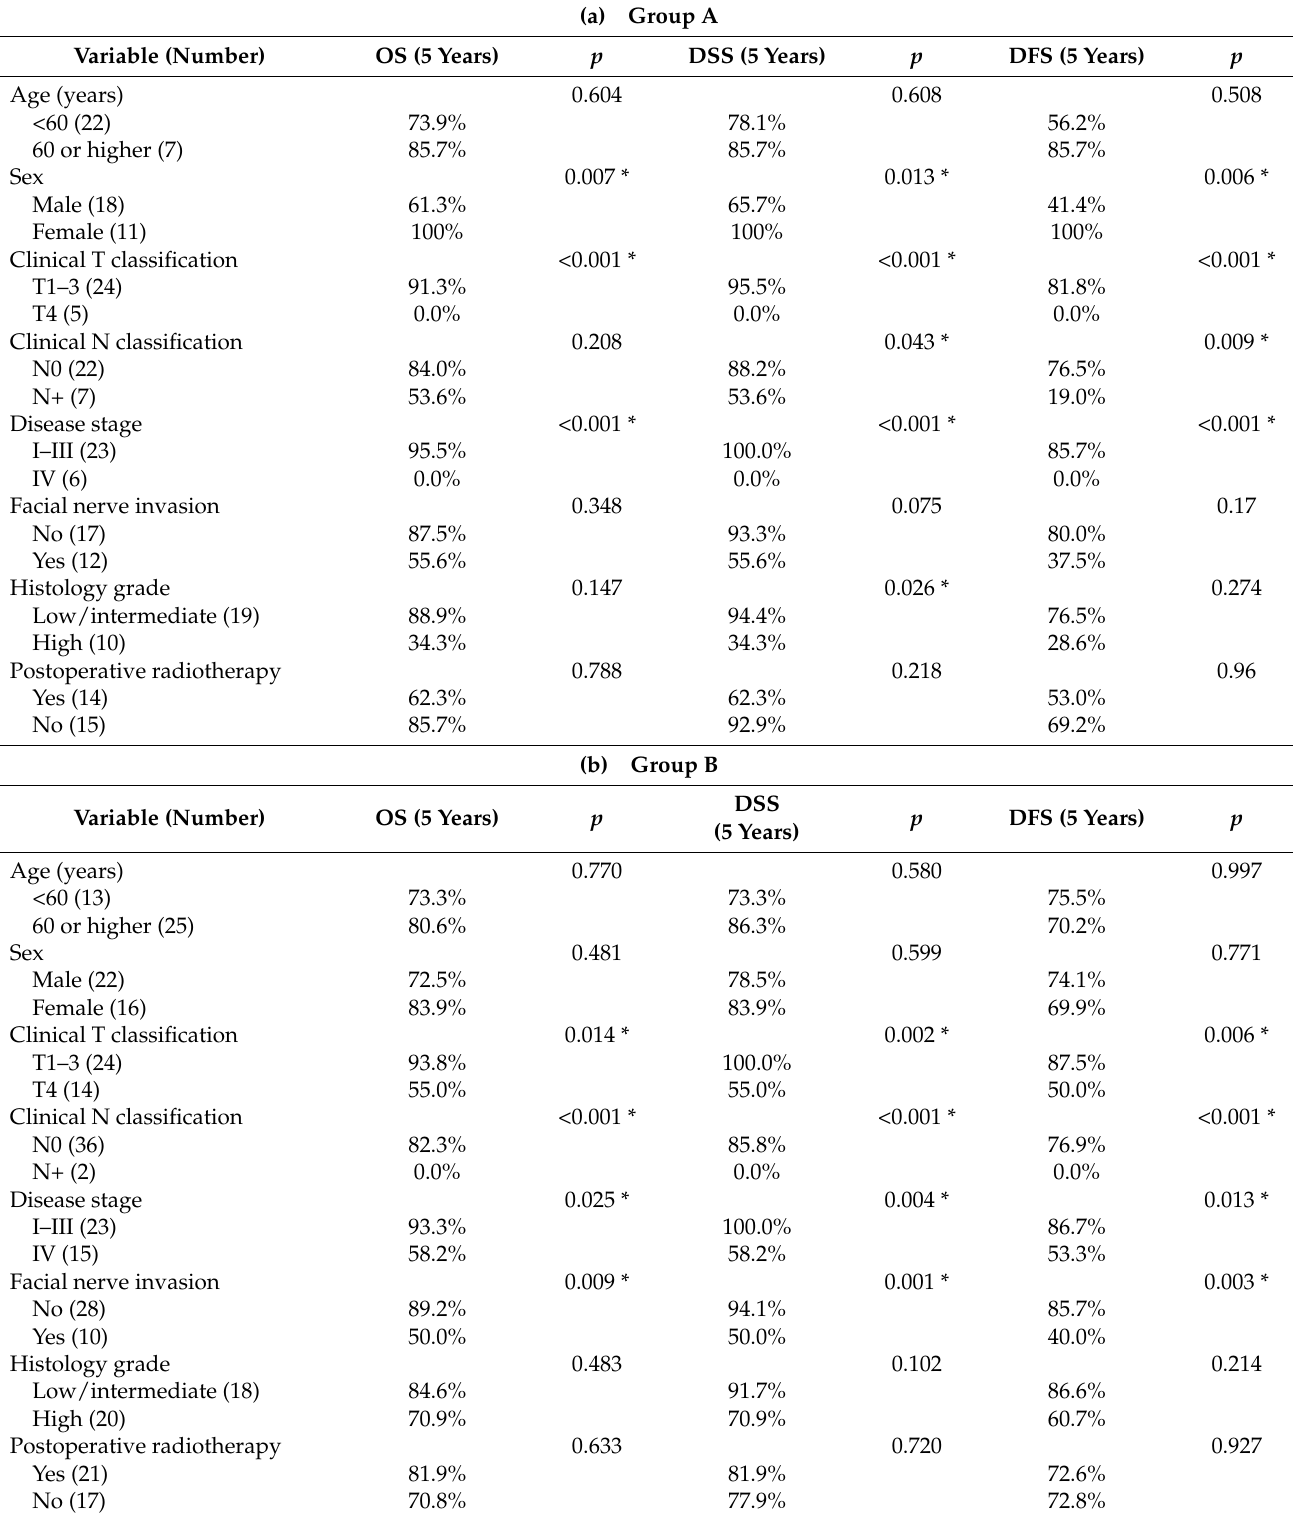
Table 3. Univariate analysis of clinicopathological factors for 5-year OS, DSS, and